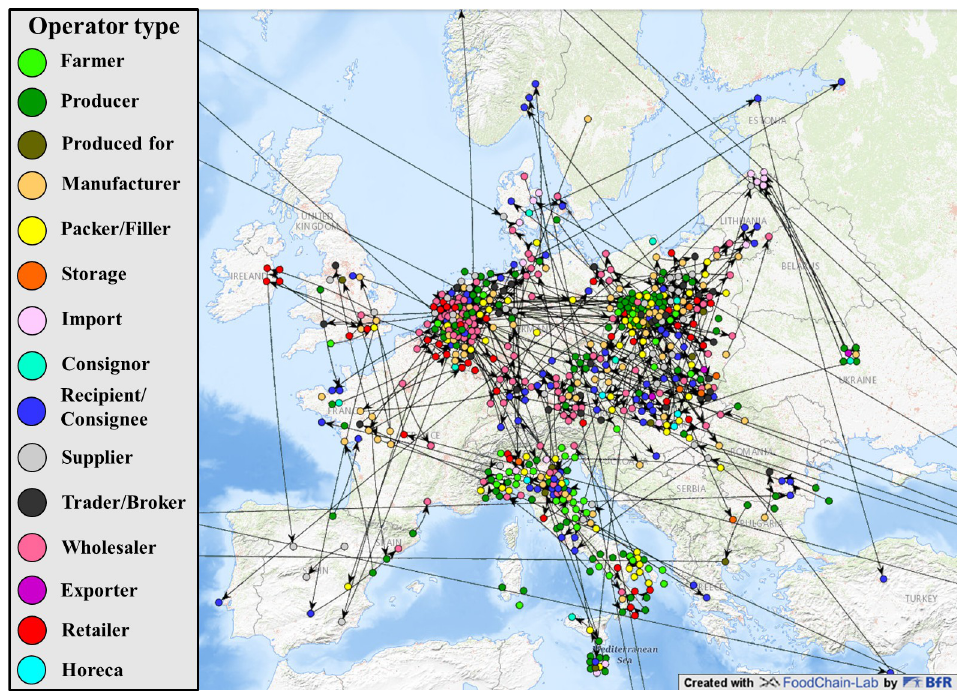
Fig 4. Categorization into 15 operator types (color-coded) using RASNEX 1.0 to analyze 222 RASFF notifications mapped using a Geographic Information System (GIS). It visualizes a total of 540 unique operators of various flows of food products, located in 40 countries and comprises information contained in RASFF for several food safety hazards on operators reported to be part of a European chicken egg supply network.